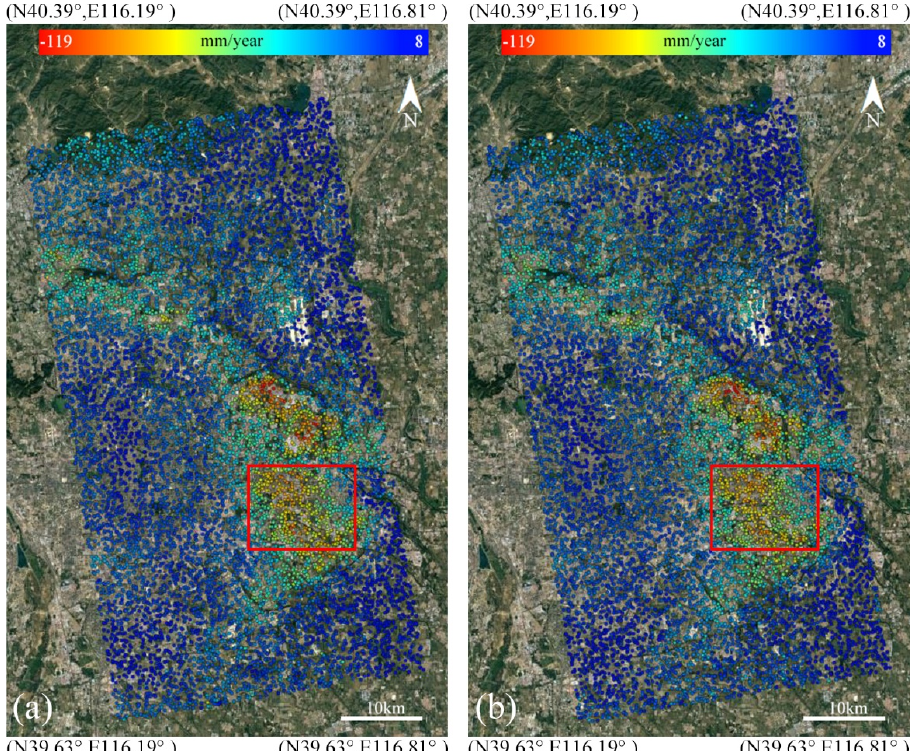
Figure 8. The deformation fields of Beijing calculated by different algorithms. ( a ) Deformation field calculated by the SBAS algorithm; and ( b ) deformation field calculated by the pseudo-combination SBAS